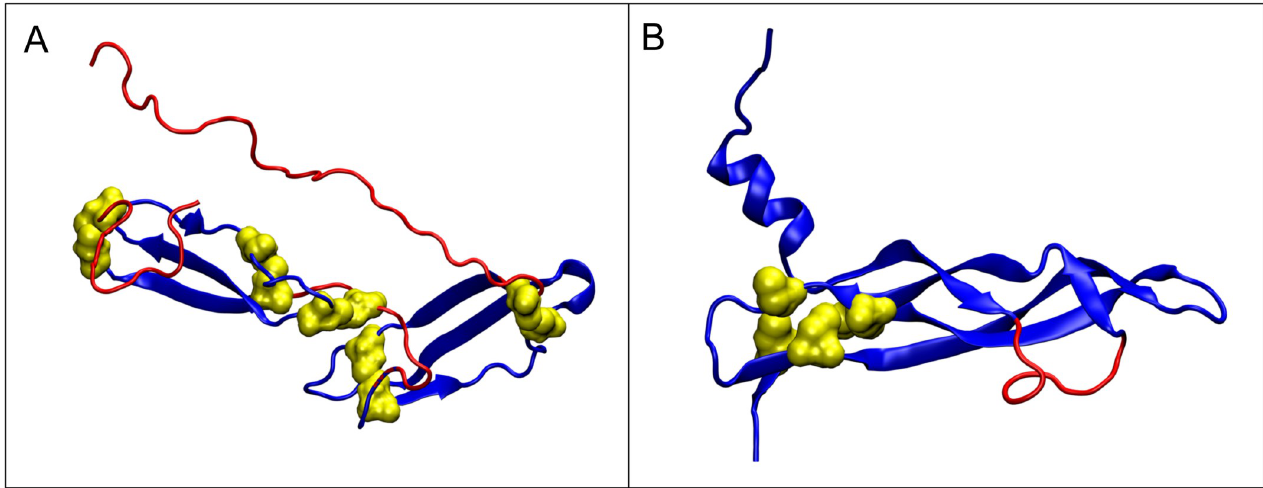
Fig 7. 3D presentation of the selected proteins with disulfide bonds present. A - 2N6F. B - 2VWE. Disulfide bonds—yellow space filling. IDRs—red.